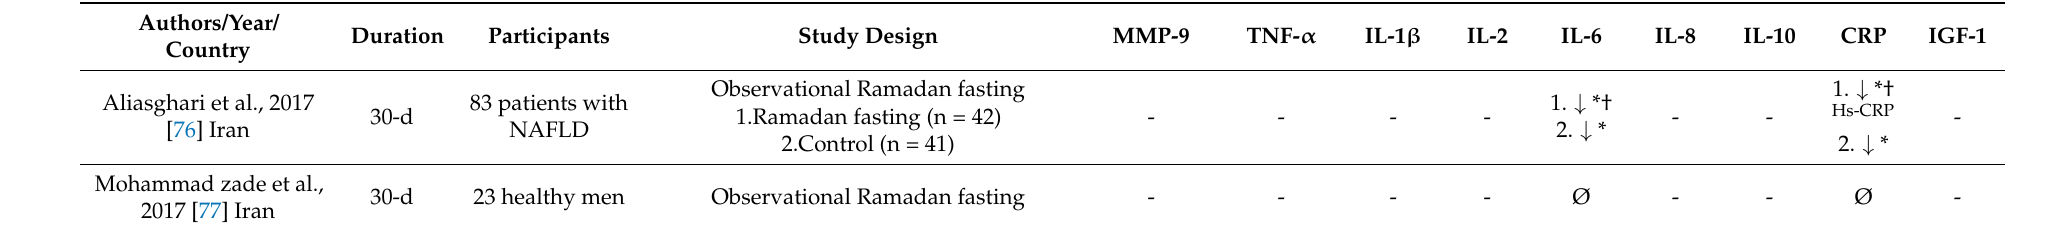
Table 3. Summary of studies on the impact of Ramadan fasting on inflammatory